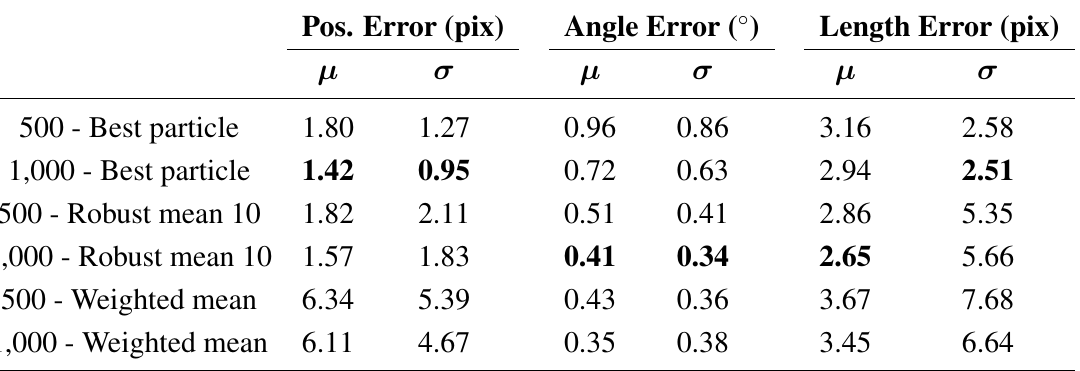
Table 1. Results of the Tracking